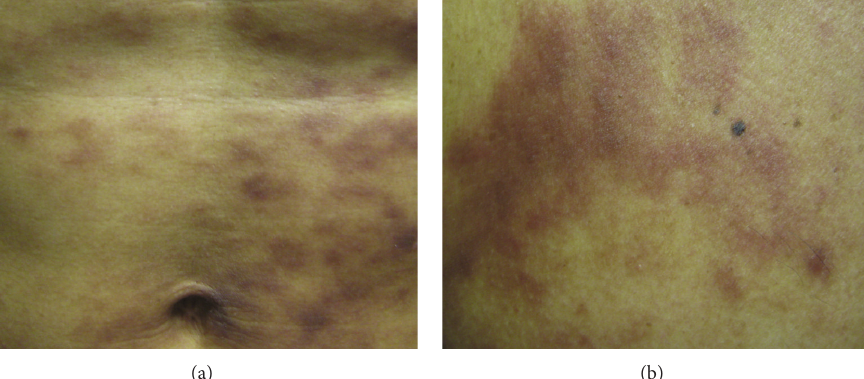
Figure 1: (a) The patient presented with brownish-red macules and mildly indurated plaques on his abdomen. (b) Similar lesions were present on his chest.